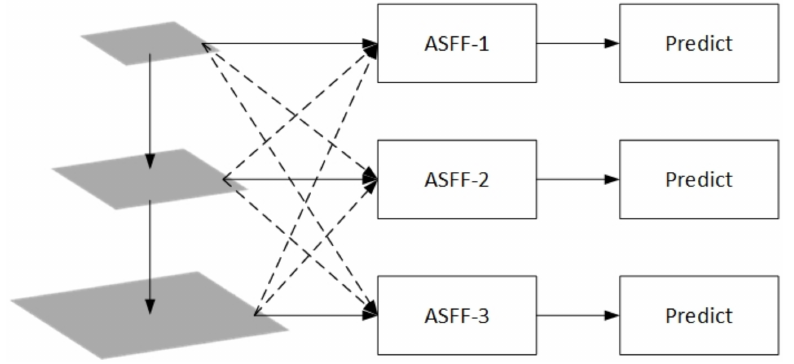
Figure 5. Add ASFF module at the end of the